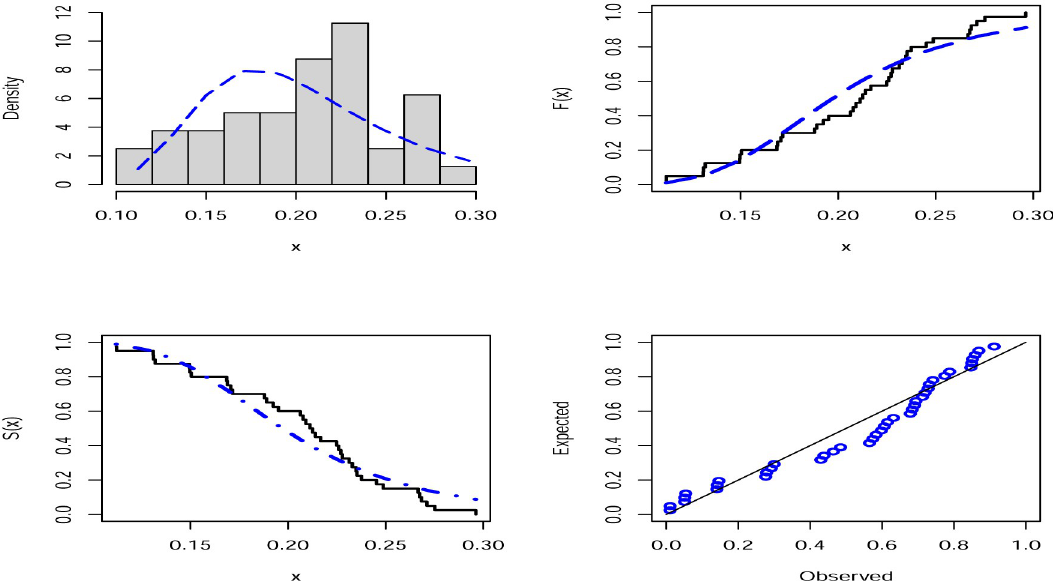
Fig 6. Histogram of the second COVID-19 real data set with the fitted PDF, CDF, SF and P-P plots.